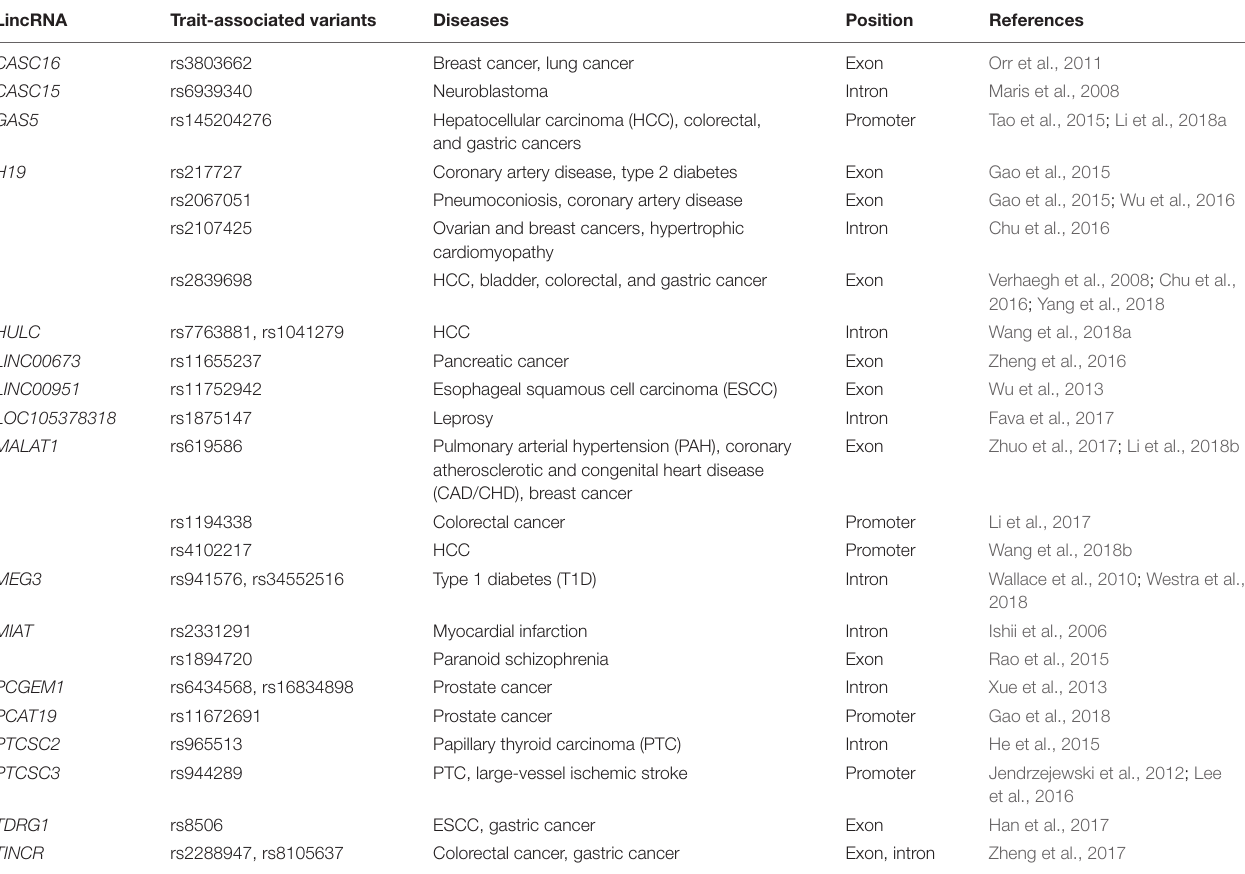
TABLE 2 | Overviews of other lincRNAs encompassing trait-associated